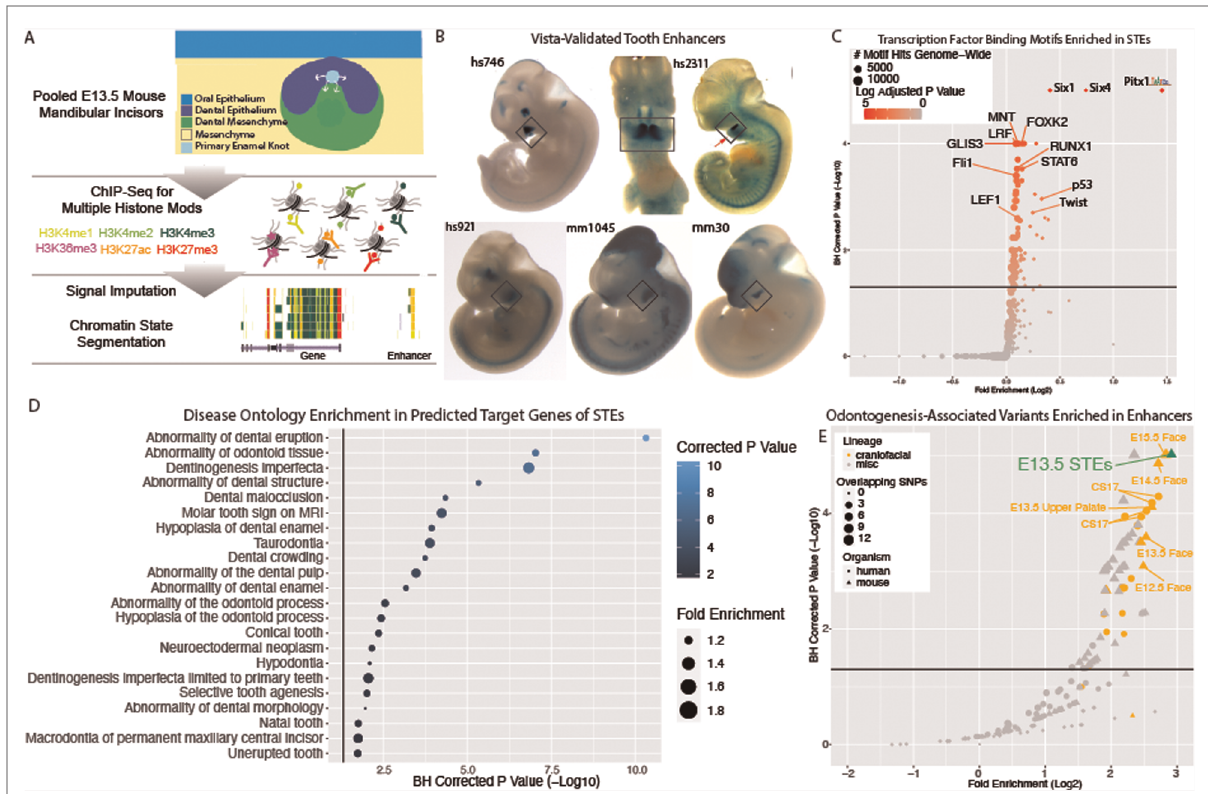
FIGURE 2 Enhancers of the developing tooth Are enriched for dental phenotype variants and target tooth development genes. ( A ) Schematic of ChIP-seq experiment and chromatin state annotation pipeline of E13.5 mouse mandibular incisors. ( B ) Selected VISTA-validated (58, 89) craniofacial enhancers which overlap TSEs. ( C ) Hypergeometric Optimization of Motif Enrichment (HOMER) (90) analysis of known transcription factor binding motifs enriched within tooth speci fi c enhancers. Position weight matrices are demonstrated for each motif, obtained from JASPAR (133). ( D ) Dental disease ontology categories enriched in putative target genes of STEs, as assigned by Genomic Regions Enrichment of Annotations Tool (GREAT) (58). ( E ) GREGOR (60) analysis of enrichment of “ Odontogenesis ” (GO_0042476)-associated variants from GWAS Catalog in active enhancers annotated by 18 state chromatin segmentations genome-wide for samples from (40) (orange circles), Roadmap Epigenome (grey circles), and our own 18 state segmentations from ENCODE craniofacial ChIP-seq samples (orange triangles), E13.5 incisor (green) and other samples (grey triangles). Dotted line indicates log adjusted p -value threshold (1.3). Tooth speci fi c enhancers (TSEs) do not pass signi fi cance threshold and cannot be evaluated for